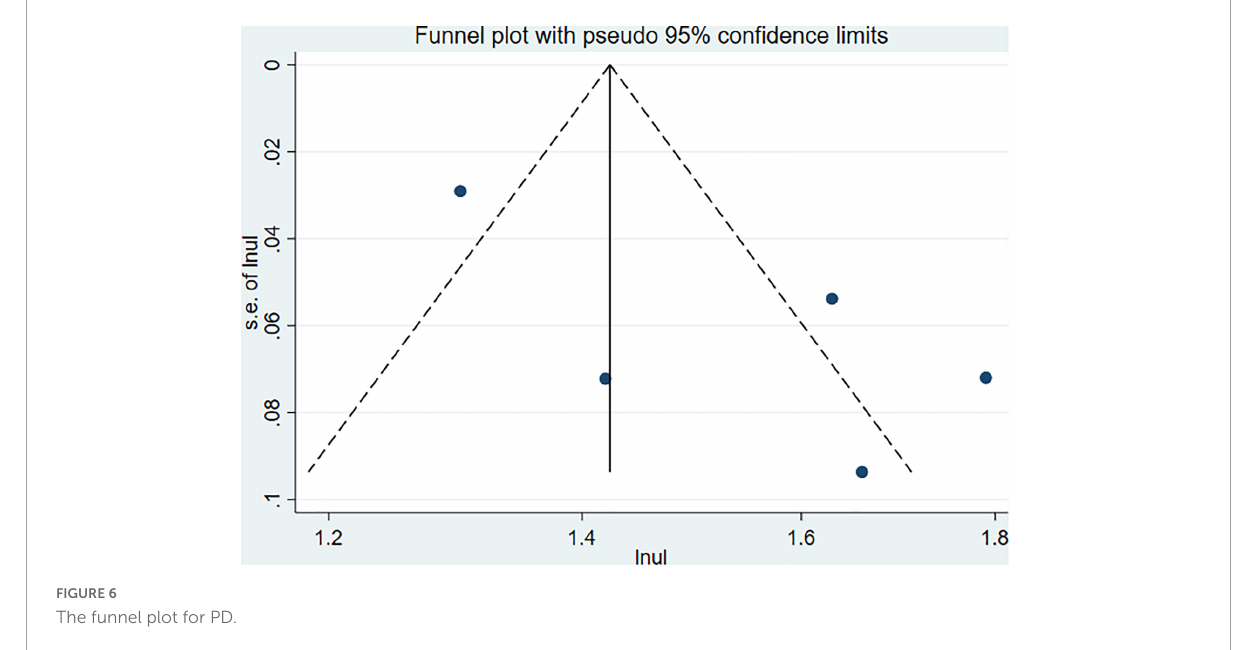
FIGURE6 The funnel plot for PD.